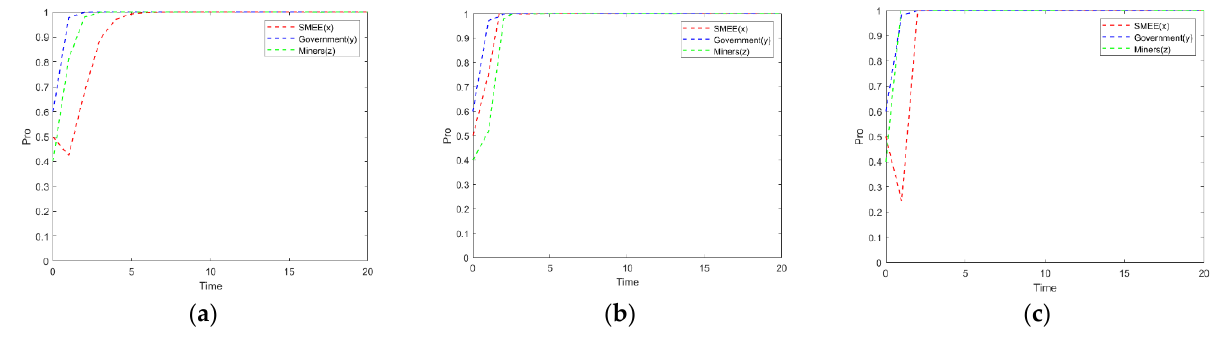
Figure 3. C a = 4.6 , strategy evolution process of the three game subjects under 3 emotional states of the miner. ( a ) 𝑟 1 = 𝑟 2 = 𝑟 3 = 1 ; ( b ) 𝑟 3 < 1 , 𝑟 1 = 𝑟 2 = 1 ; ( c ) 𝑟 3 > 1 , 𝑟 1 = 𝑟 2 = 1 .